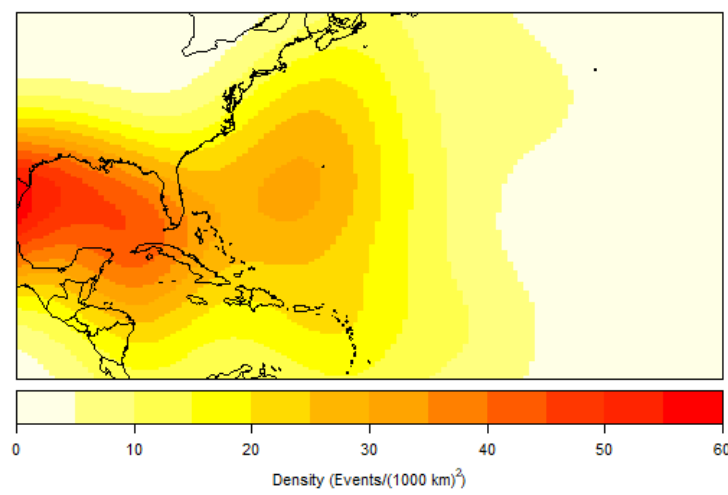
Figure 15. Kernel density analysis of RI hurricanes at their LMI points (1851 – 2017).